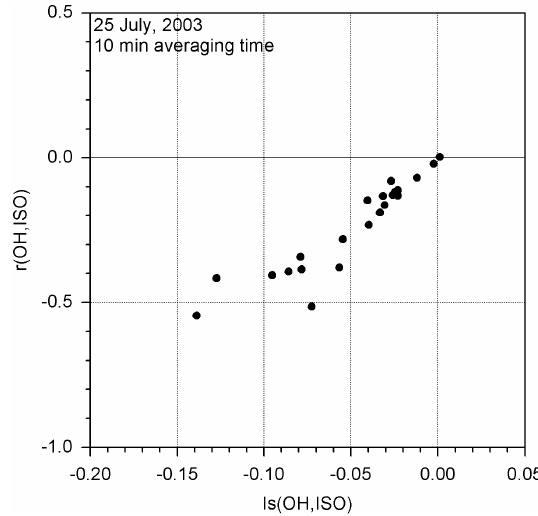
Figure 9. The correlation coefficient between isoprene and OH as a function of segregation intensity I S